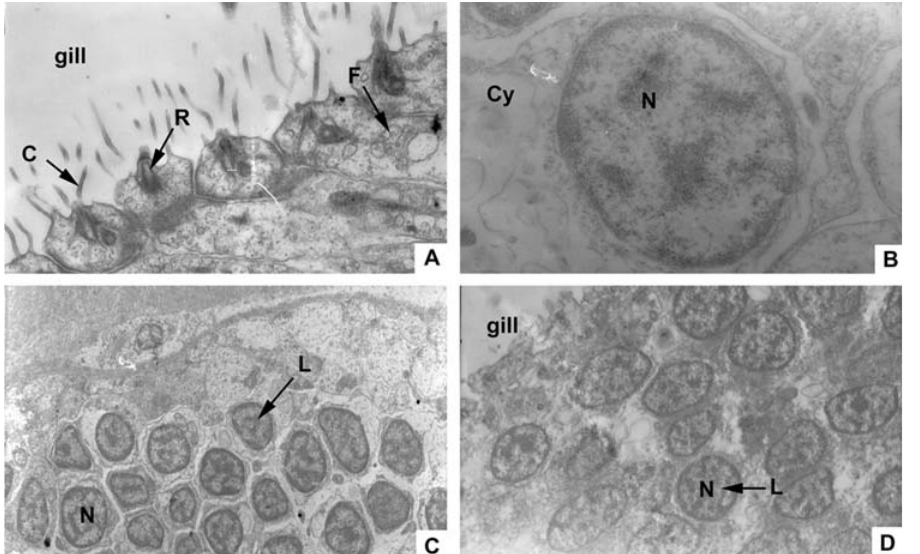
Figure 2. Transmission electron-microscopic views of the lymphocyte-like cells in follicle-associated epithelium of amphioxus gill. (A) Follicle- associated epithelium cells in the gill contained follicle (F) rootlet (R), and cilia (C). Magnification 29000. (B) The lymphocyte-like cells contained large nuclei (N) with heterochromatin forming a peripheral rim adjacent to the nuclear envelope. Magnification 48000. (C) Under the FAE of normal amphioxus gill, lots of lymphocyte-like cells (L) were seen. The cells contained large nuclei (N) with heterochromatin forming a peripheral rim adjacent to the nuclear envelope. Magnification 5800. (D) At the same magnification, after the microbial challenge, the lymphocyte-like cells were bigger than those of normal